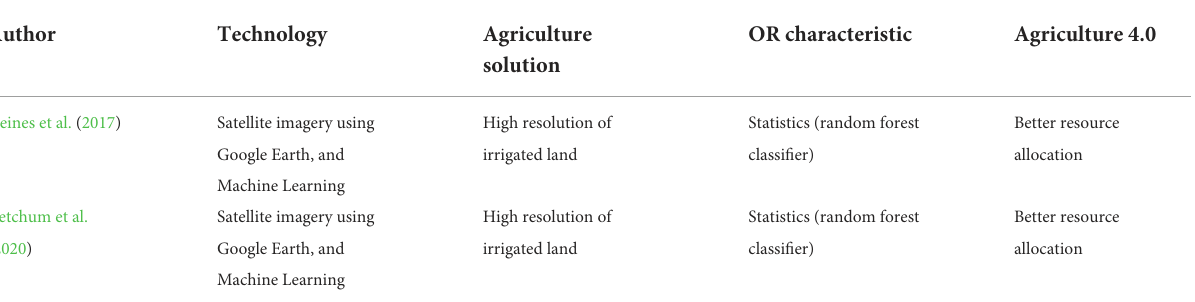
TABLE 7 Research stream: ML for precise agriculture